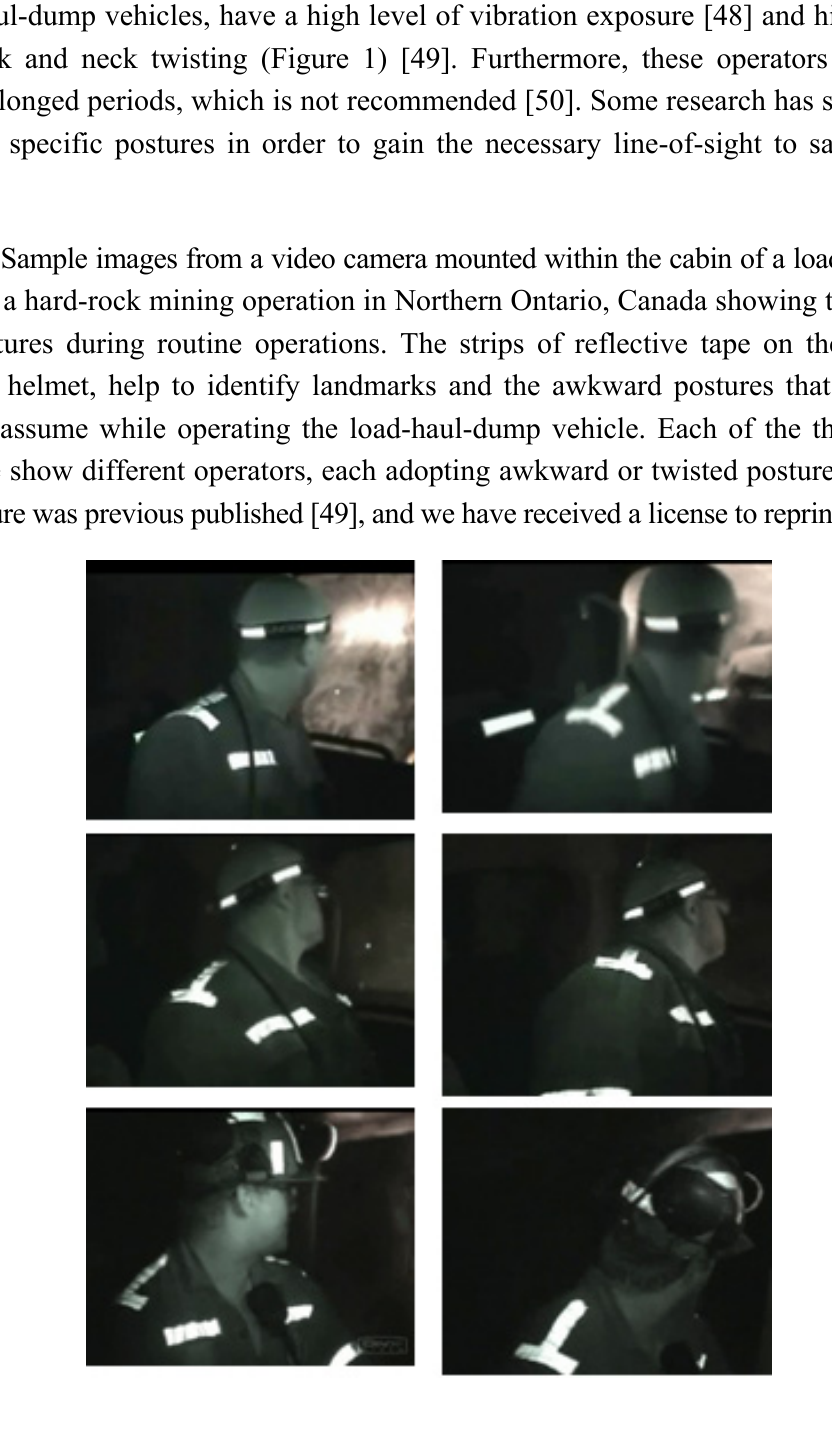
Figure 1. Sample images from a video camera mounted within the cabin of a